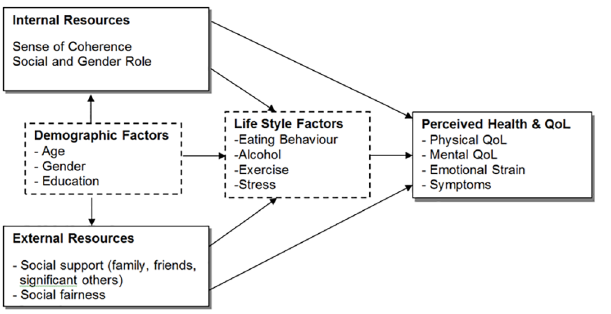
Fig 1. Conceptual model of perceived health and quality of